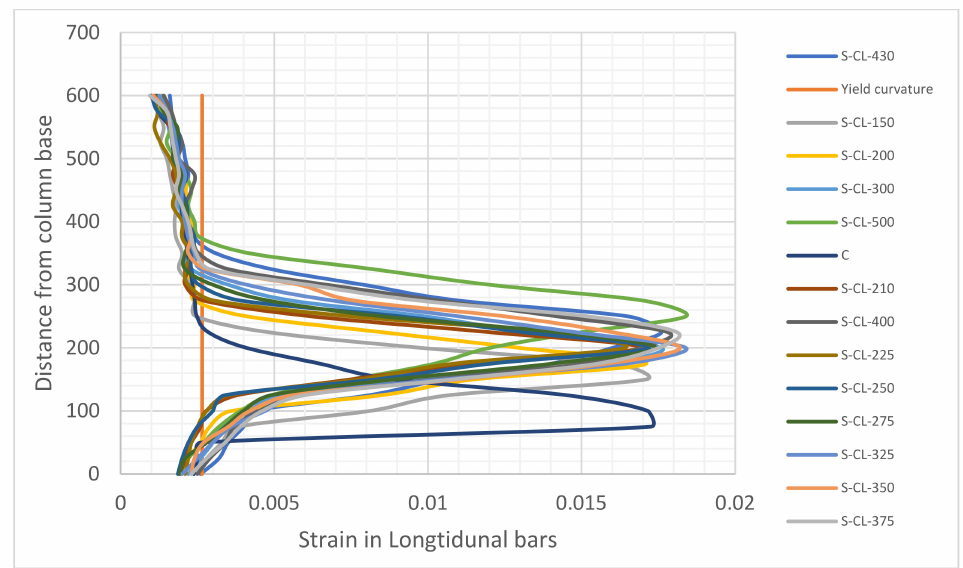
Figure 9. Distribution of axial strain in the longitudinal